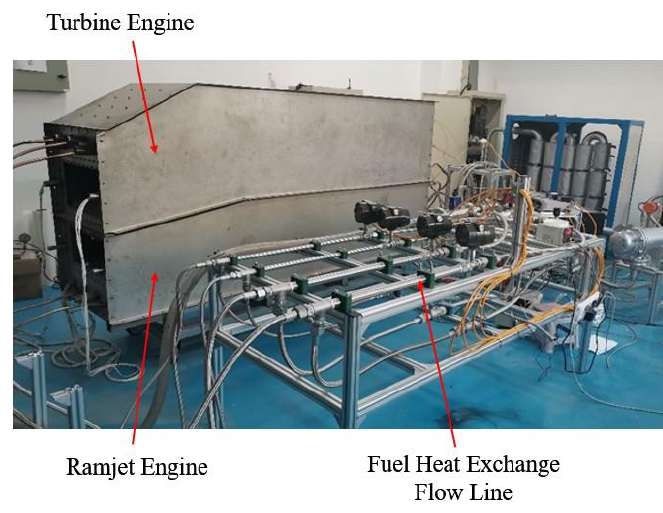
Figure 7. Experimental platform.